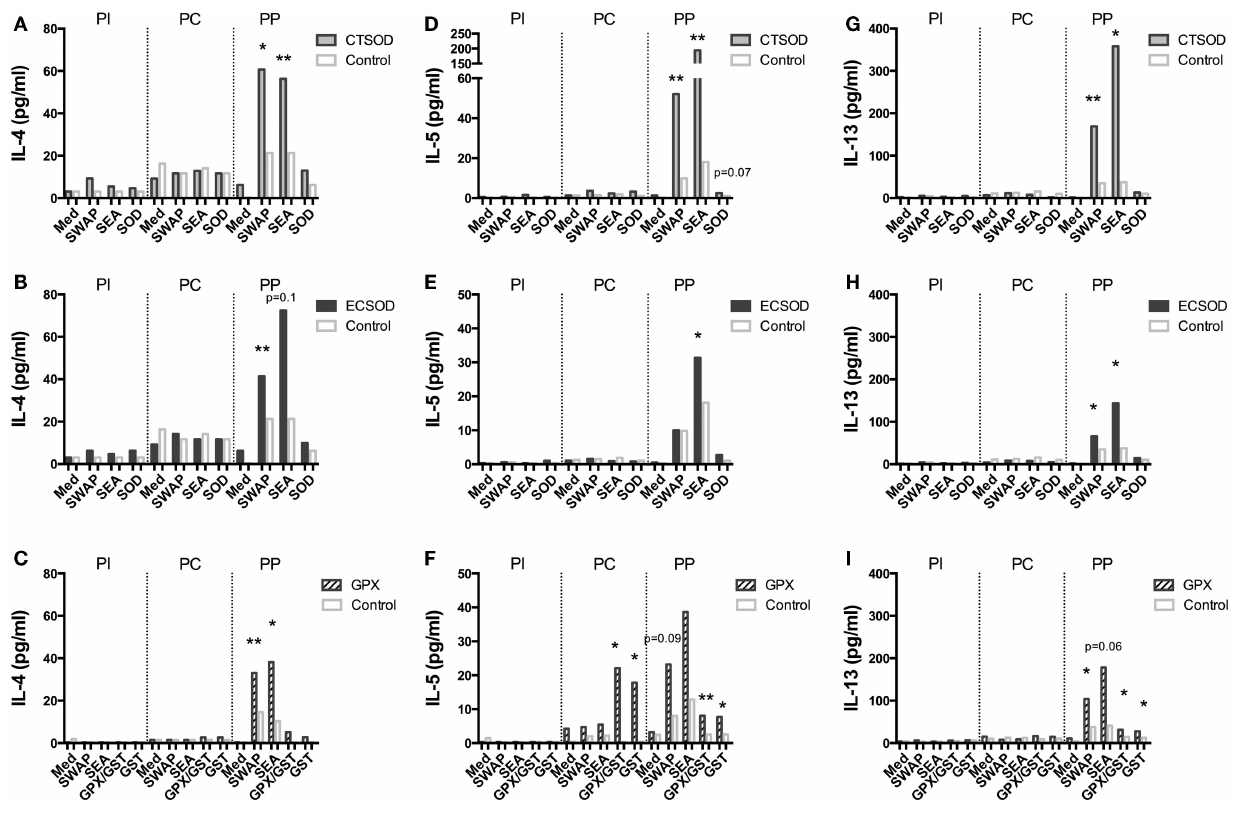
Figure 8 | secretion of cytokines in supernatants from experiment 2 . PBMCs from CTSOD (a,D,g) , ECSOD (B,e,h) , and GPX (c,F,i) groups ( n = 5 animals per group) were stimulated 72 h with crude and recombinant antigens and secreted IL-4, IL-5, and IL-13 levels determined, before vaccination (PI), before challenge (PC), and at perfusion (PP). Values were